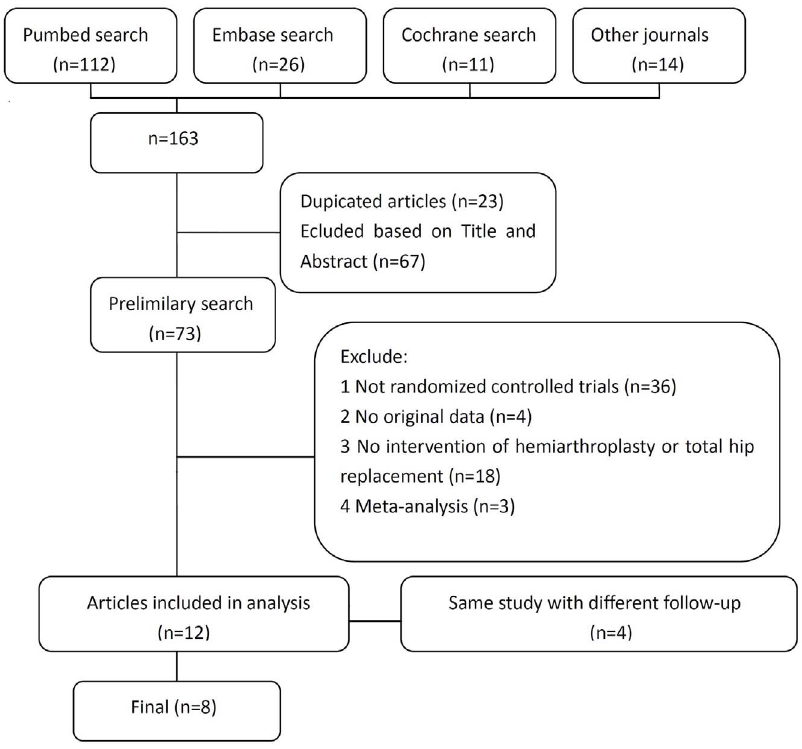
Figure 1. Flow chart of the studies recruited in this meta-analysis.